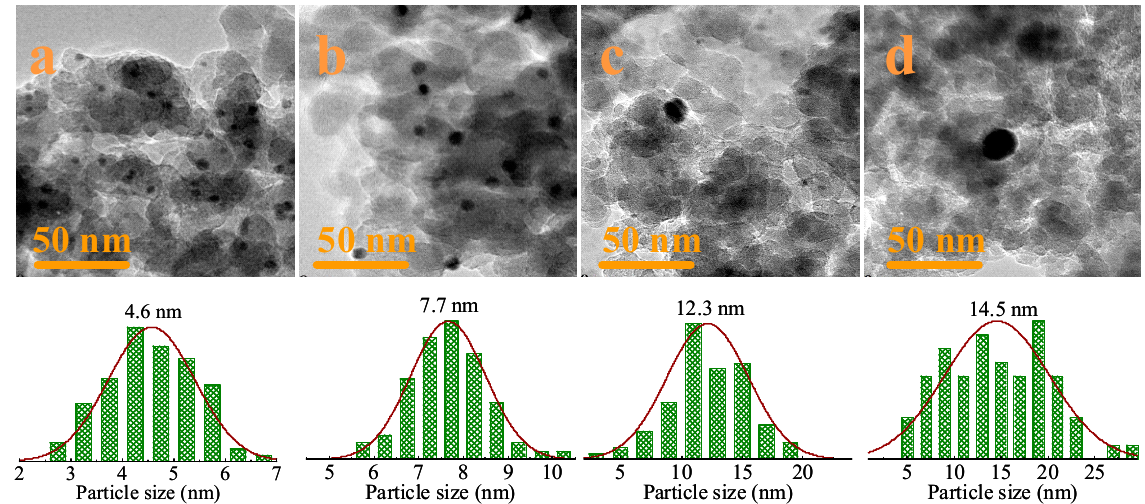
Figure 1. TEM images and Pd particle size distribution curves of the Pd/SiO 2 - R catalysts prepared by the dry ball-milling method with different Pd precursors (after the dry ball-milling of fumed silica (SiO 2 ) together with Pd precursor for 1 h, the Pd/SiO 2 - R catalysts was calcined in air at 400 °C for 4 h and then reduced with hydrogen at 400 °C for 1 h): ( a ) Pd/SiO 2 -Acac, ( b ) Pd/SiO 2 -OAc, ( c ) Pd/SiO 2 -Cl, and ( d ) Pd/SiO 2 -NO 3 .